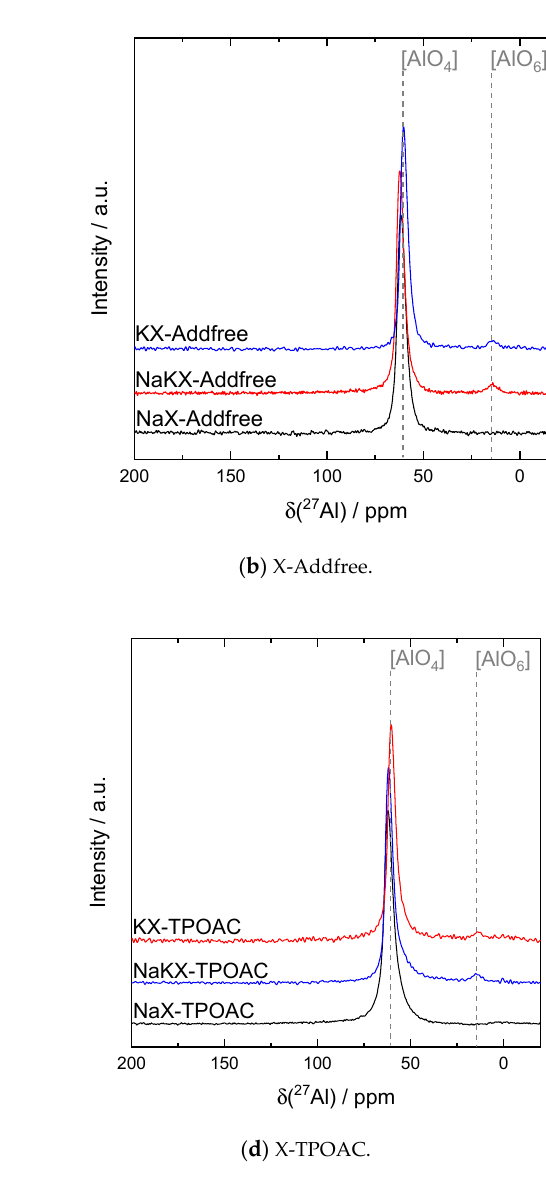
Figure 5. Solid-state 27 Al NMR spectra of the zeolite X materials with conventional morphology ( a ), layer-like morphology via temperature reduction ( b ), layer-like morphology due to the addition of Li 2 CO 3 ( c ), and the addition of organosilane ( d ). Each zeolite is shown before and after the first ion exchange and after the sixth ion exchange. For all four parent zeolite samples (NaX), solely one large signal at 62 ppm was visi- ble, which was indicative for tetrahedrally coordinated aluminium. A signal at around 15 ppm, which would be indicative for (AlO 5 )- or (AlO 6 )-species, i.e., external aluminium species [22], was not found. This allows the conclusion that all four synthesis routes pre- sented in this study led to a (within the detection limits of solid-state NMR) complete incorporation of aluminium atoms in the zeolite framework.